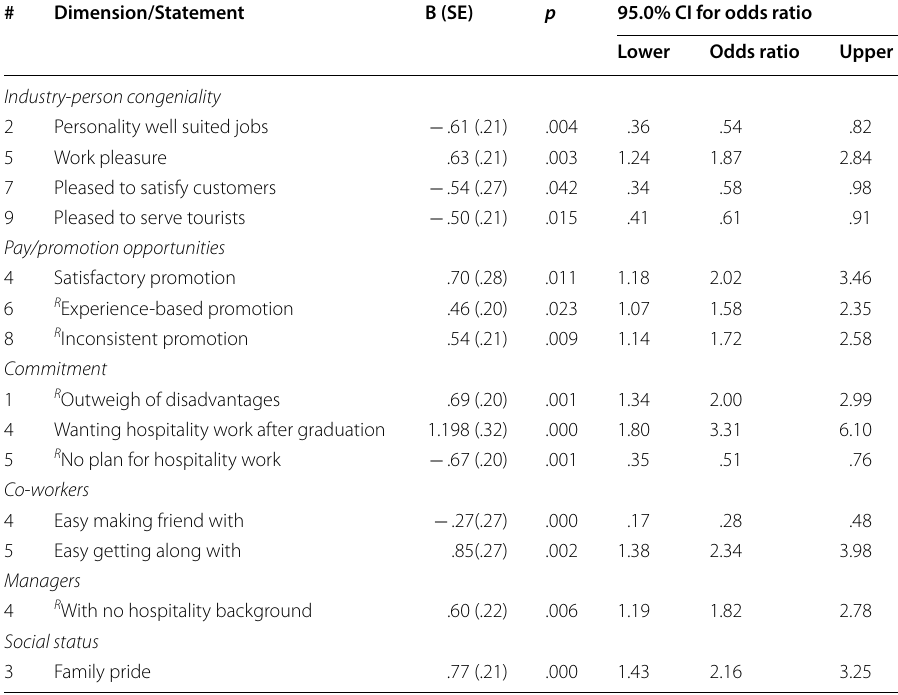
Table 6 Summary of logistic regression results, by model, of predictors reporting the student